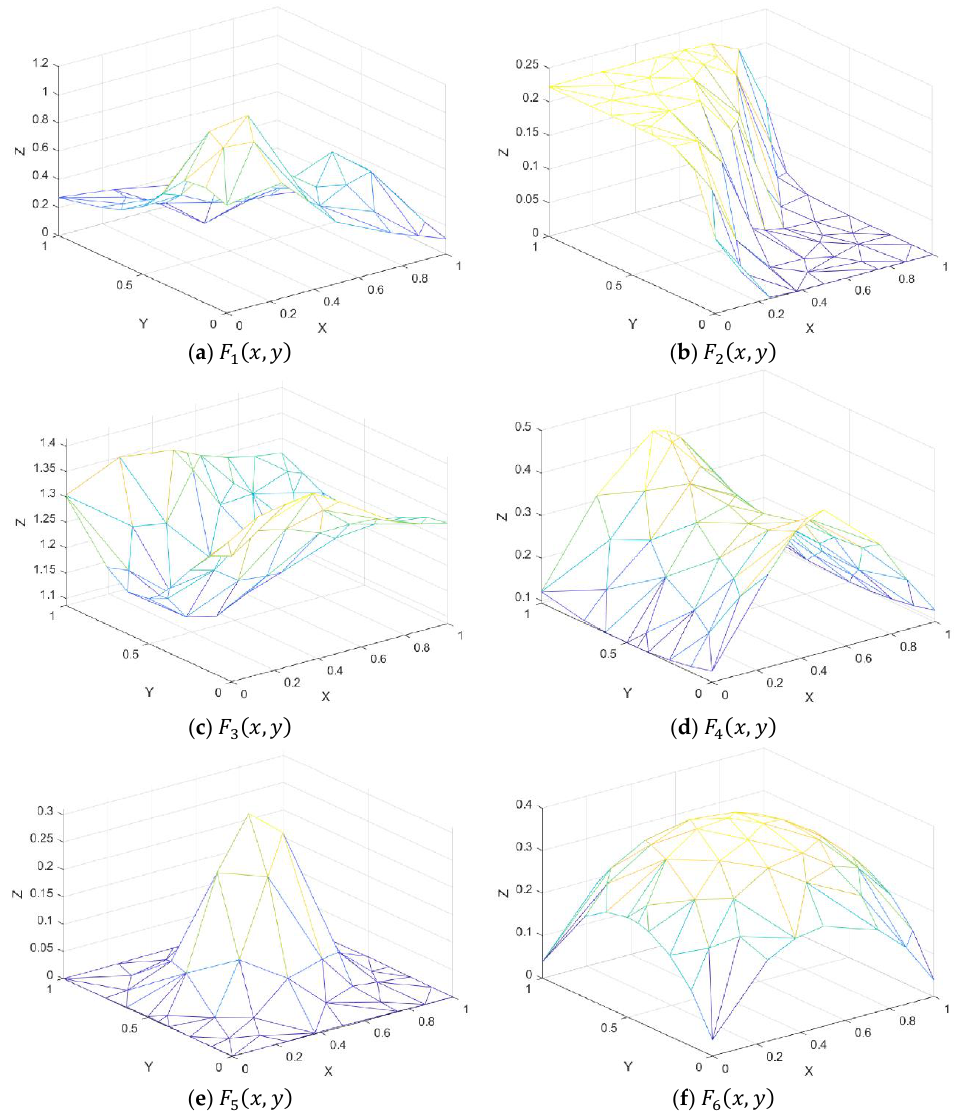
Figure 10. 3D linear interpolant for 65 datasets.